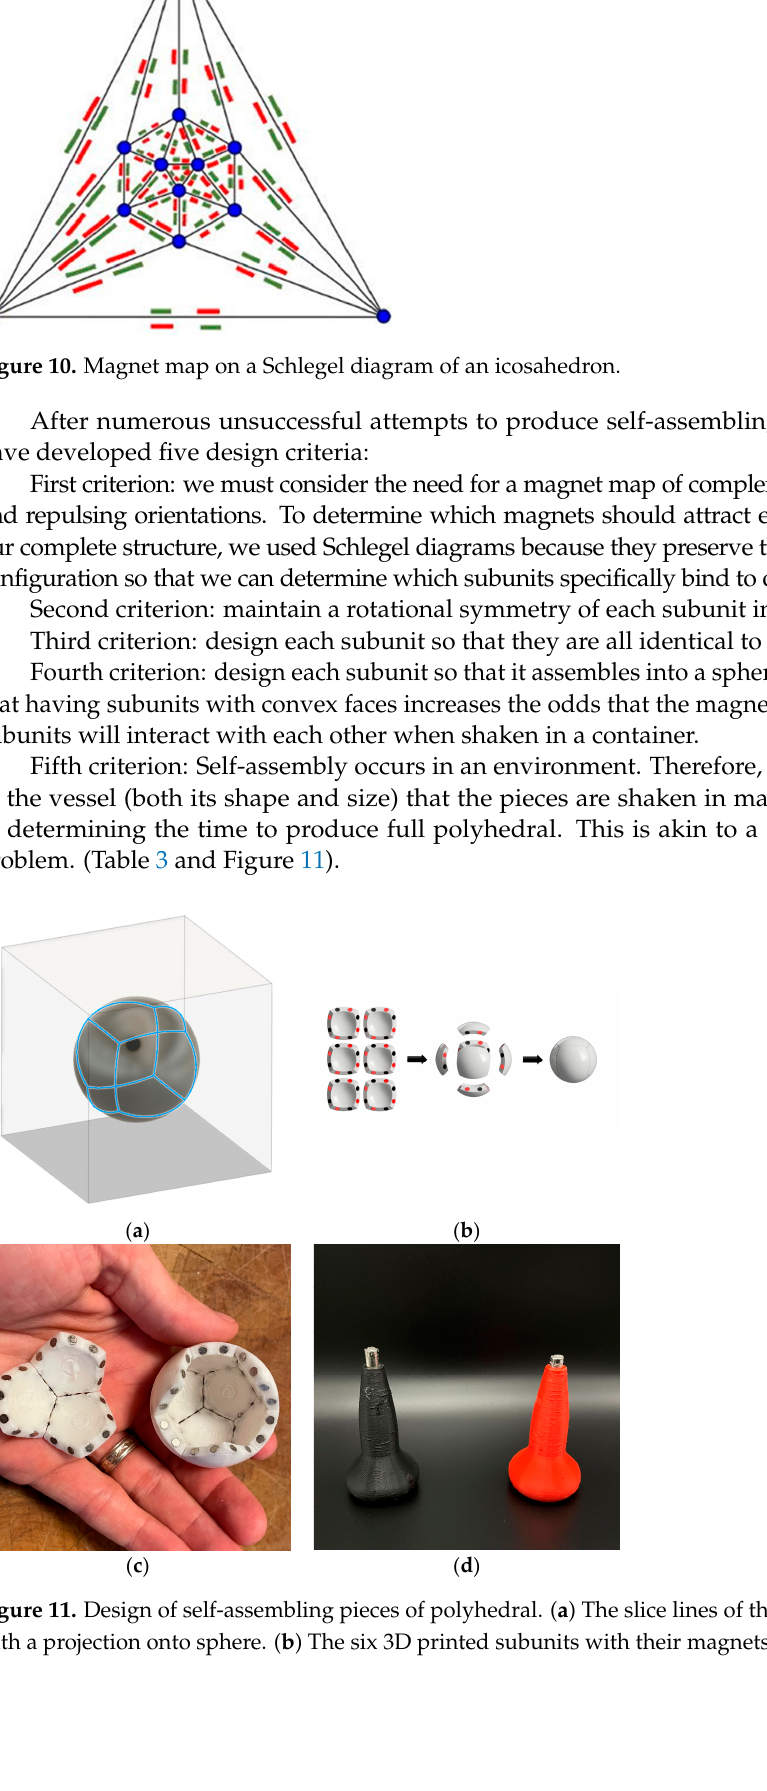
Figure 11. Design of self-assembling pieces of polyhedral. ( a ) The slice lines of the six faces of a cube with a projection onto sphere. ( b ) The six 3D printed subunits with their magnets alternating around each edge of the faces and their assembly back into a sphere. ( c ) Illustration of three and nine pen- tagon subunits of a partial dodecahedron viewed from the interior. ( d ) North and south oriented magnet holders for correctly inserting magnets into holes on the edges of subunits in a pattern dic- tated by the Schlegel diagram magnet mapping (see Figure 8). Thus, self-assembly occurs not only much faster on average in spherical containers than in cylindrical containers, but the several of the experiments in cylindrical containers were not successful in generating complete icosahedra. Combined, these five criteria help to increase the speed at which a given design cor- rectly self-assembles, as the pieces can assemble in many different orientations. For each of the five Platonic solids one can glue a north facing and a south facing magnet on each edge of a convex subunit to achieve these goals. We have, for the first time, successfully produced self-assembling tetrahedra, cubes, octahedra, dodecahedra, and icosahedra models based upon these criteria. However, to better model polyhedral viral capsids we wanted to build models using rhombic cells (icosahedral asymmetric units) such as shown in Figure 3 for a T1 virus. Therefore, we built a self-assembling decahedron of ten rhombi made by simply dividing a sphere into the 20 equilateral triangular faces but keeping ten pairs glued together